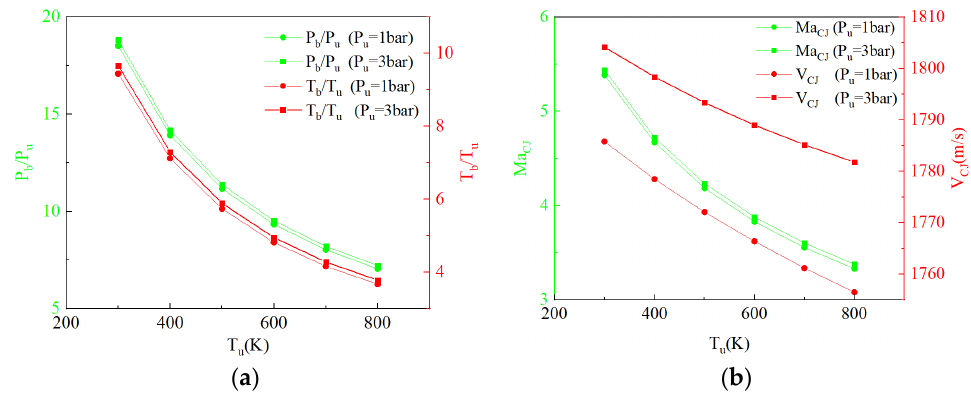
Figure 11. Effects of air temperature on intensity of detonation wave. ( a ) Static pressure ratios and static temperature ratios. ( b ) Mach number before detonation wave and wave velocity.